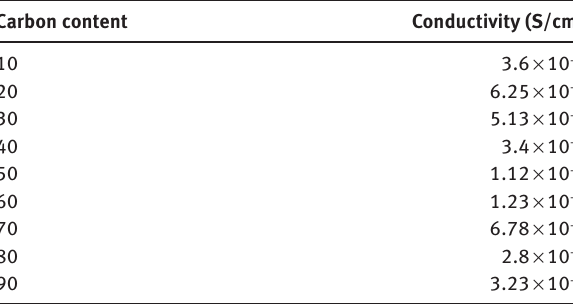
Table 1: Variation of conductivity with different carbon